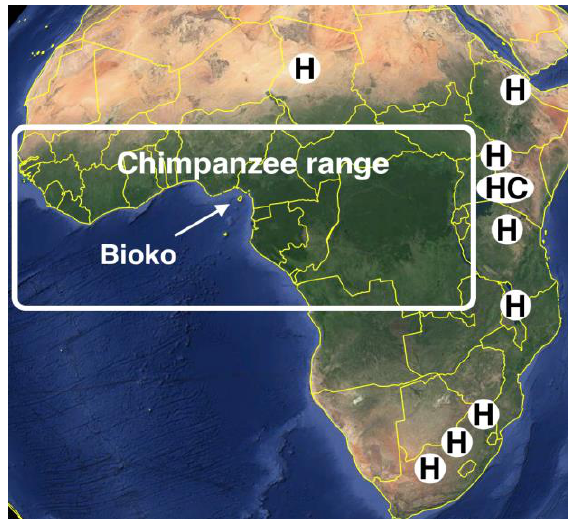
Figure 1 . Range of chimpanzees in historic times. (None on Bioko or other islands of the Cameroon Volcanic Line.) Letters H and C indicate hominin and chimpanzee fossil sites, all of which are outside the current range of chimpanzees. Base map from Google